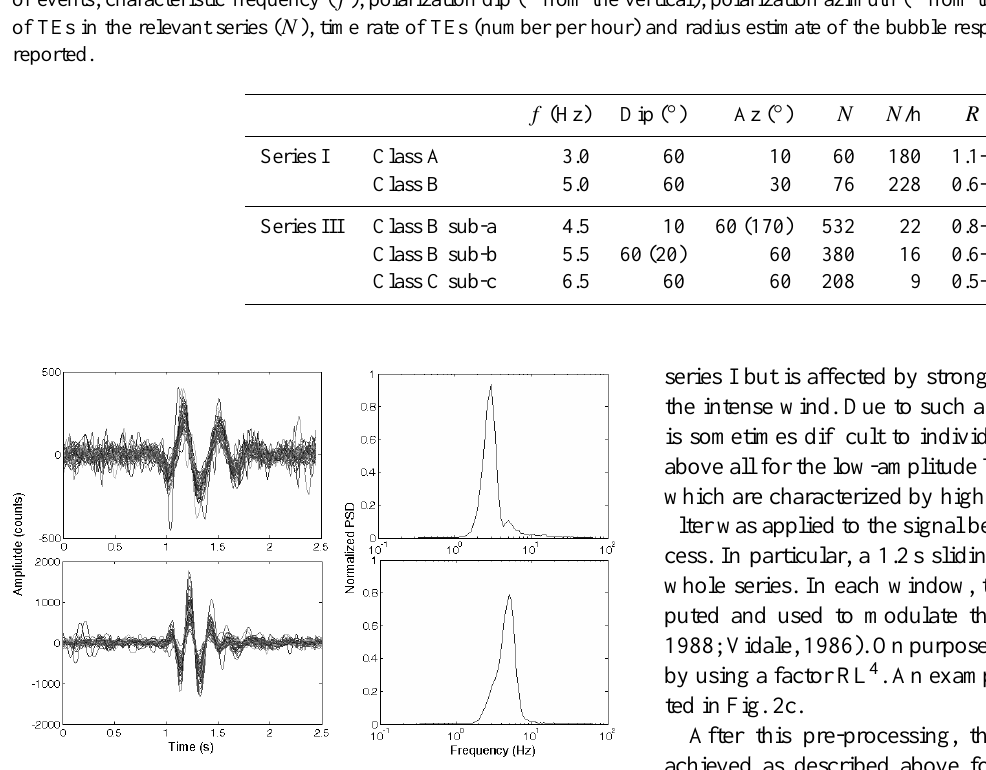
Fig. 3. Stacking of “events” detected in the Series I (on the left) and corresponding spectra (on the right). The upper plots refer to events of Class A and the lower ones to Class B (see text for details). The events were normalized on the respective amplitude before staking. The spectra refer to the mean pattern obtained for each of the two kinds of